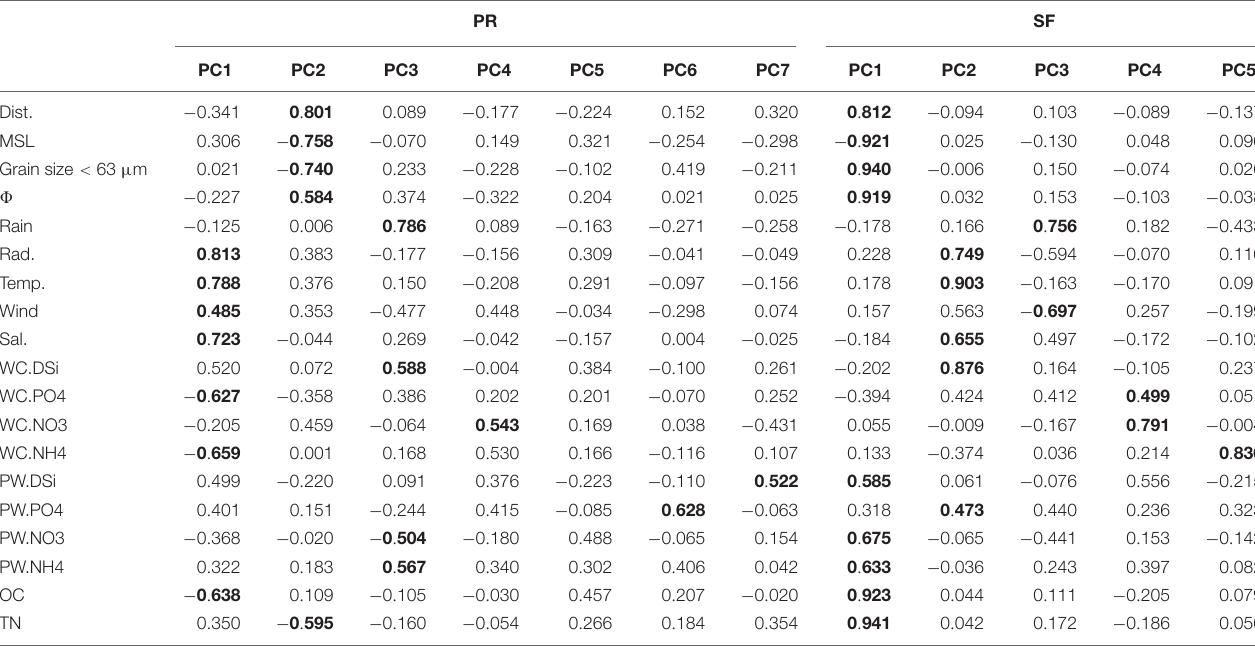
TABLE 1 | Correlation coefficients between environmental variables and significant components obtained by principal components analysis (wherein the selected components account for over 80% of environmental variability) for each of the two transects studied in Puerto Real (PR) and San Fernando (SF) seasonally during on year.